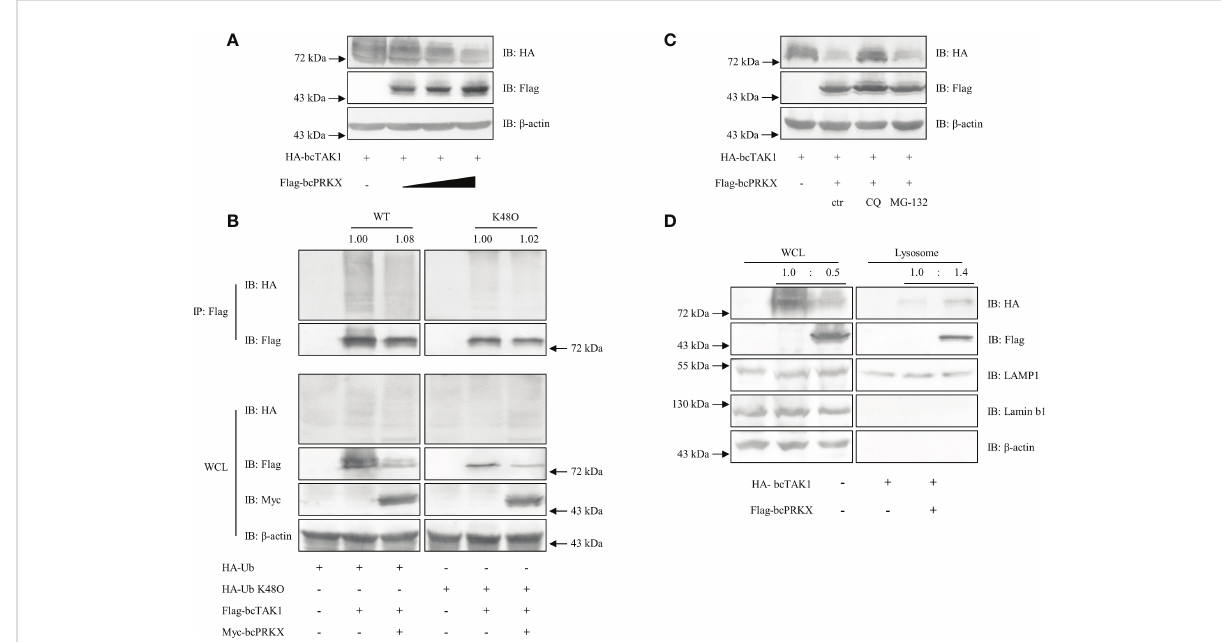
FIGURE 9 bcPRKX-mediated degradation of bcTAK1. (A) HEK 293T cells in a 6-well plate were co-transfected with bcTAK1 and bcPRKX (with the increasing dosage). The transfected cells were harvested for immunoblotting at 48 h post-transfection. (B) HEK 293T cells in a 10 cm diameter petri dish were co-transfected with HA-Ub, Flag-bcTAK1 and/or Myc-bcPRKX separately. The transfected cells were harvested for immunoprecipitation and immunoblotting at 48 h post-transfection. (C) HEK 293T cells in a 6-well plate were co-transfected with bcTAK1 and bcPRKX and the transfected cells were subjected to chloroquine (CQ) or MG-132 treatment at 8 h before being harvested for immunoblot. (D) HEK 293T cells in a 6-well plate were transfected with bcTAK1 alone or co-transfected with bcTAK1 and bcPRKX. The cells were harvested at 48 h post-transfection for lysosome isolation and immunoblotting. IB for LAMP1 was used for lysosomal internal reference.